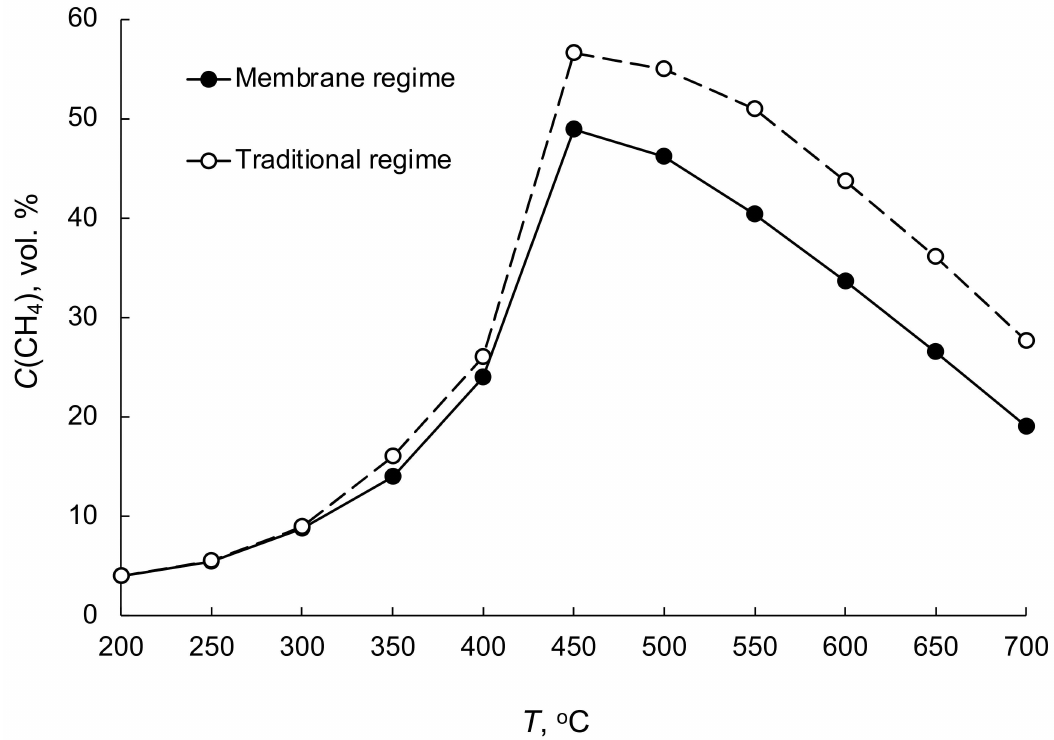
Figure 12. Comparison of temperature dependences of methane concentrations in the products of steam reforming of dimethyl ether in membrane and traditional